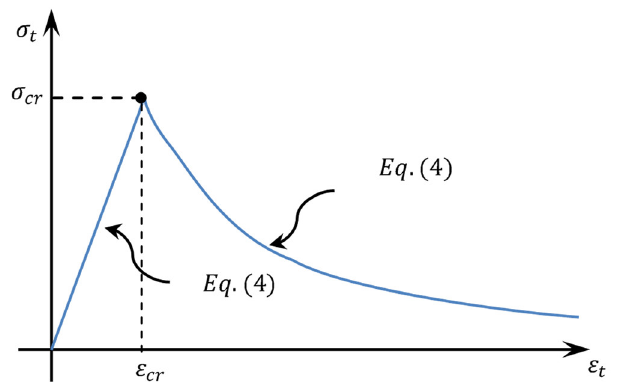
Figure 5. The σ t – ε t curve of concrete under tension.